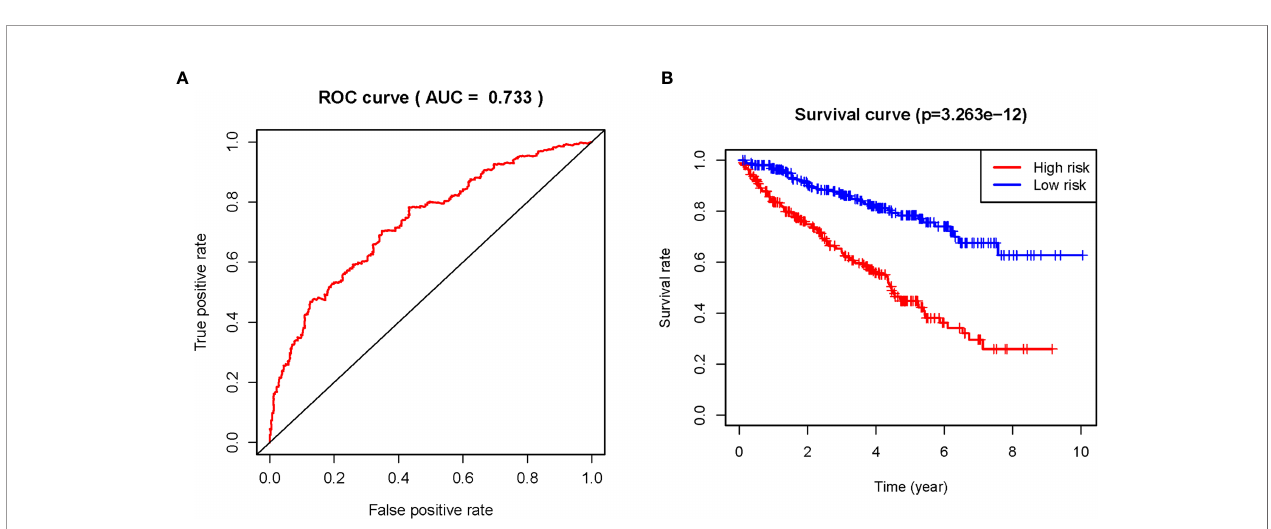
FIGURE 4 | (A, B) The relationships between ARGs and sARLNRs. A Sankey diagram was used to visualize the relationships between lncRNAs, mRNAs, and risk